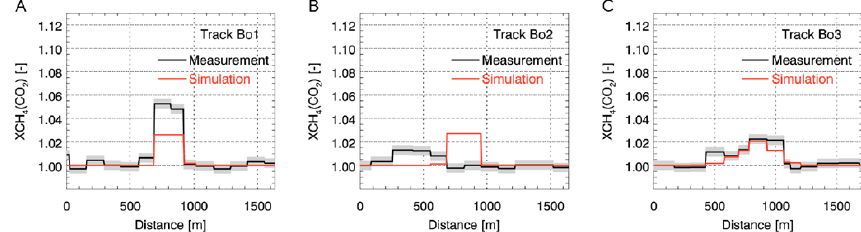
Fig. 15. As Fig. 14 but for Bockraden Shaft. Figure 11 shows the position of the cross